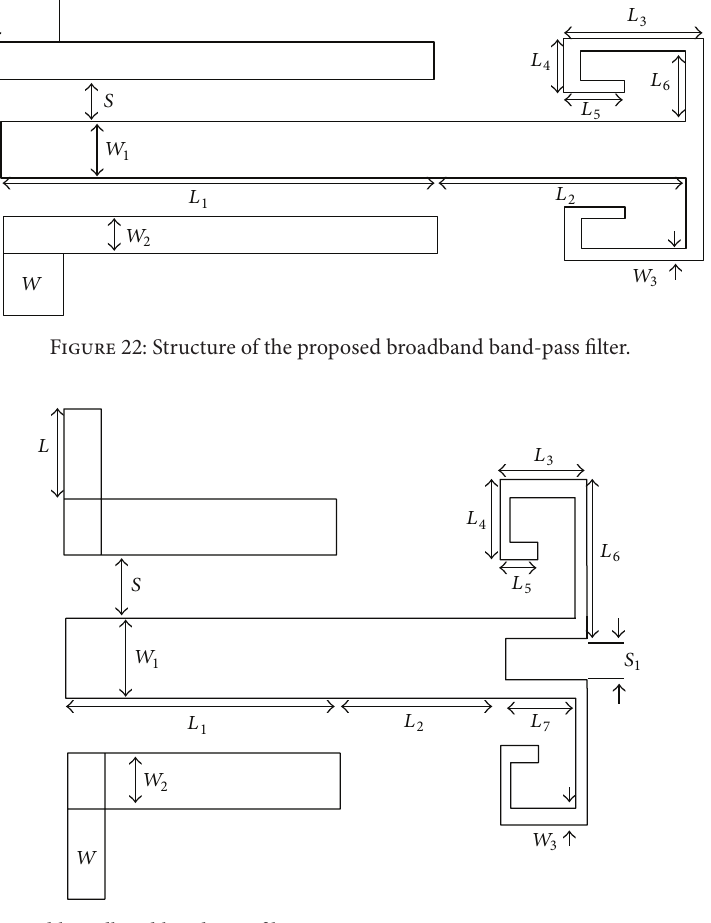
Figure 23: Structure of the proposed broadband band-pass filter, 𝐿 = 2.2 mm, 𝐿 1 = 12mm, 𝐿 2 = 3.4 mm, 𝐿 3 = 1.6mm, 𝐿 4 = 0.5 mm, 𝐿 5 =